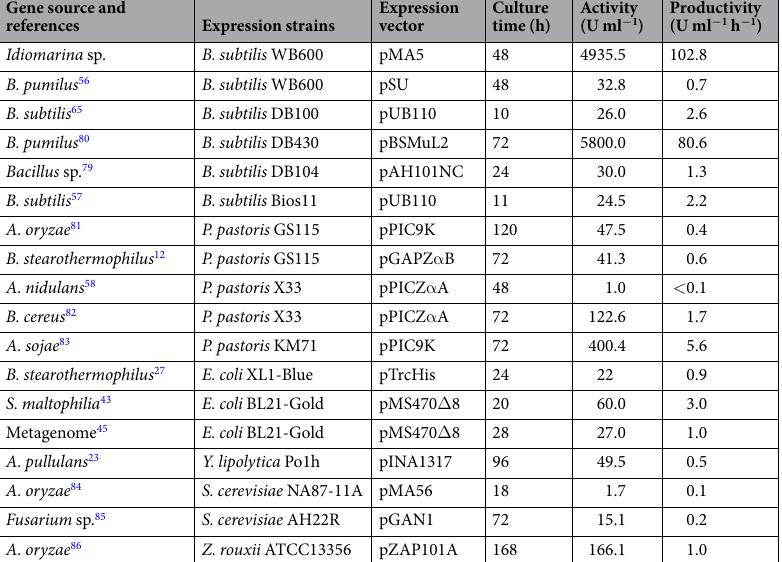
Table 6. Comparison of secretory expression of alkaline proteases in different